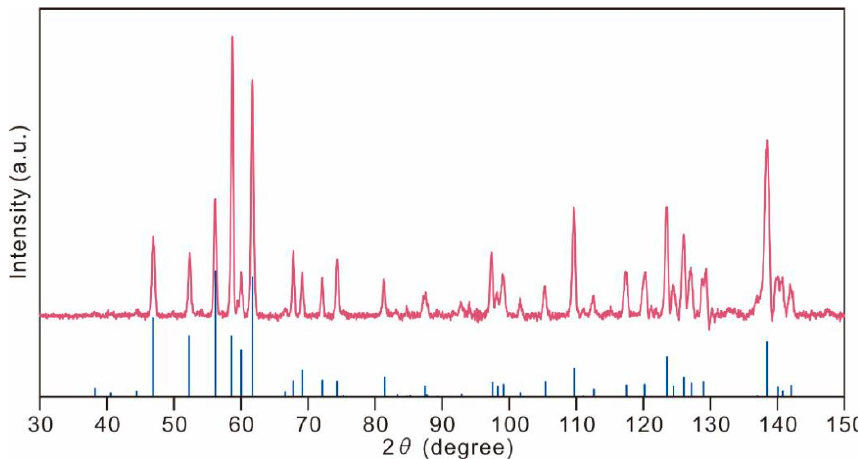
Figure 3. X ‐ ray diffraction spectrum (Cr K α radiation) of aurihydrargyrumite. The bars below the diffraction profile are the simulation calculated using the atomic position by Lindahl [2]. All of the diffraction peaks can be indexed as aurihydrargyrumite. Table 2. Powder X ‐ ray diffraction data (CrK α radiation) for aurihydrargyrumite.